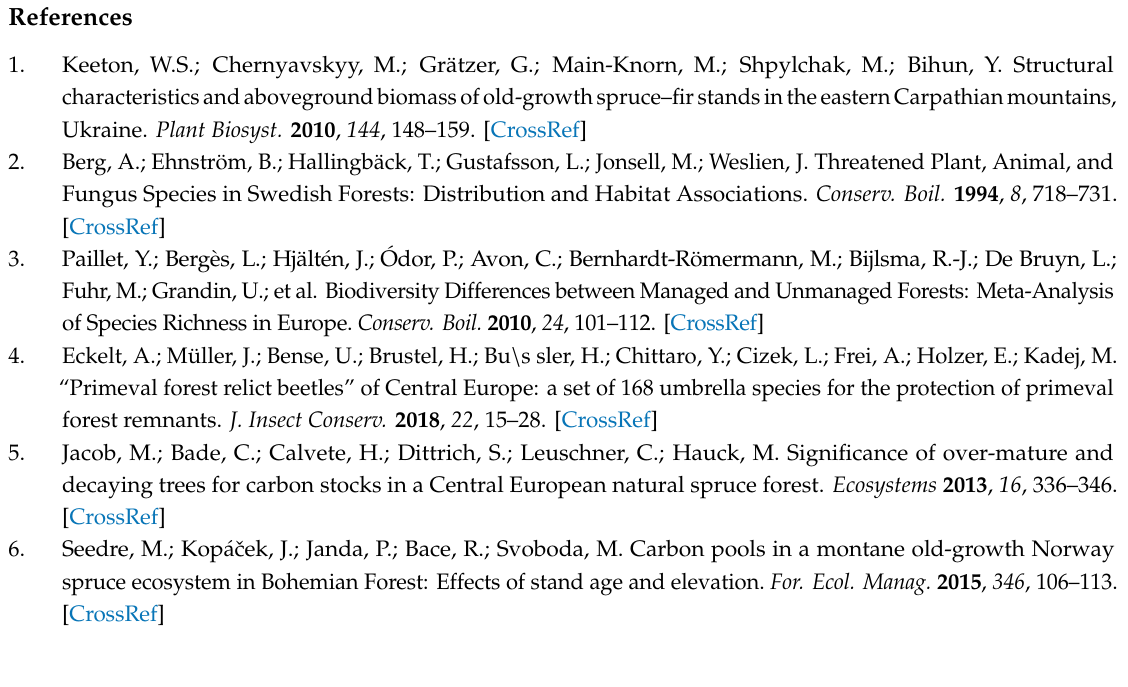
Figure S1. Boxplots of old-growth forest grouped by protection category as a function of ( a ) elevation, ( b ) slope and ( c ) distance to nearest settlement. Median: line, box: first to third quartiles, whiskers: third quartile + 1.5 × Interquartile Range (IQR) and first quartile-1.5 × IQR. Abbreviations: N.P. is National Park, R.L.P. is Regional Landscape Park, Anthro. is